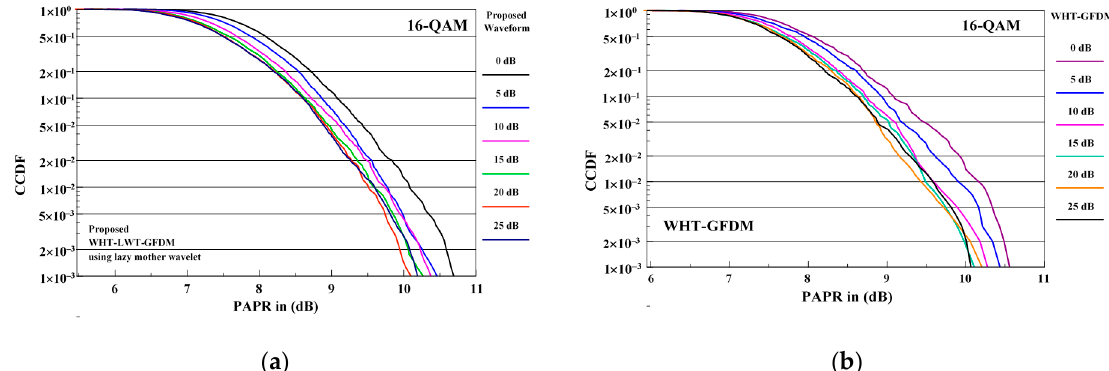
Figure 16. The PAPR performance comparison of the proposed waveform ( a ) and WHT-GFDM waveform ( b ) in between 0–25 dB of SNR values for 16-QAM modulation.